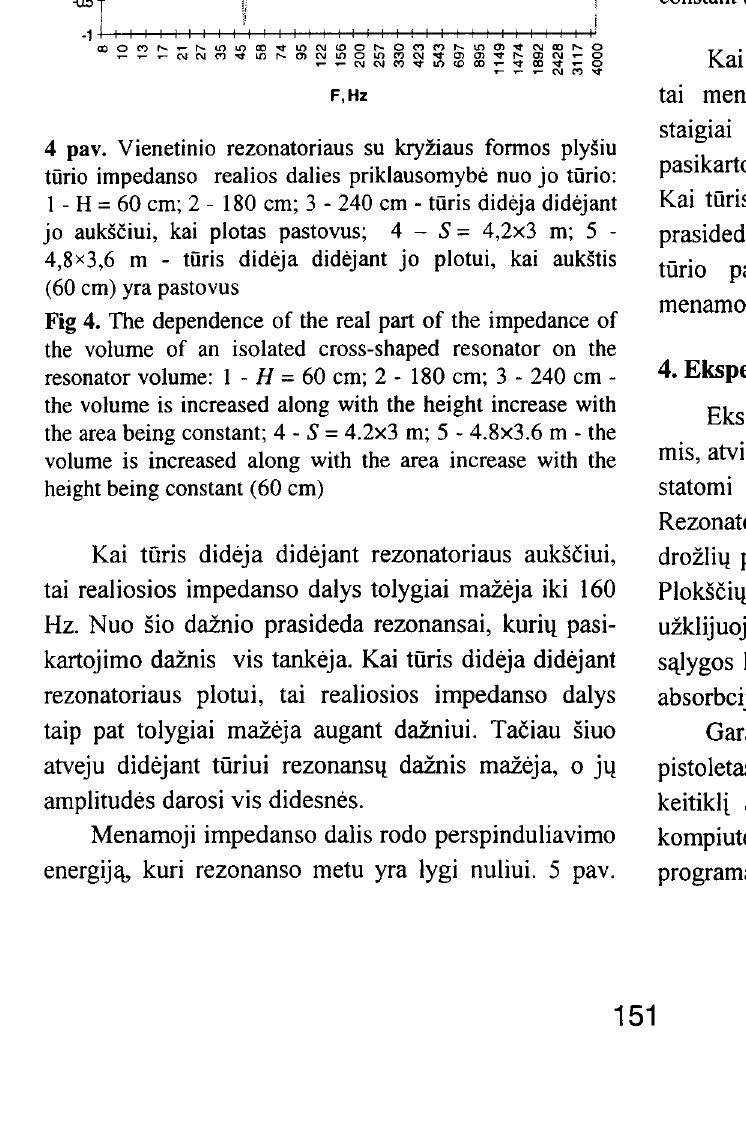
tiirio impedanso menamosios dalies priklausomybe nuo jo tiirio: I - H = 60 em; 2 - I 80 em; 3 - 240 em - tiiris dideja didejant jo auksciui, kai plotas pastovus; 4 - S = 4,2x3 m =12,6 m 2; 5- 4,8x3,6 m =17,28 m 2 - tiiris dideja didejantjo plotui, kai aukstis (60 em) yra pastovus Fig 5. The dependence of the imaginary part of the impedance of the volume of an isolated cross-shaped resonator on the resonator volume: 1 - H = 60 em; 2 - 180 em; 3 - 240 em - the volume is increased along with the height increase with the area being constant; 4 - S = 4.2 x 3 m = 12.6 m 2 ; 5 - 4.8x3.6 m = 17.28 m 2 - the volume is increased along with the area increase with the height being constant (60